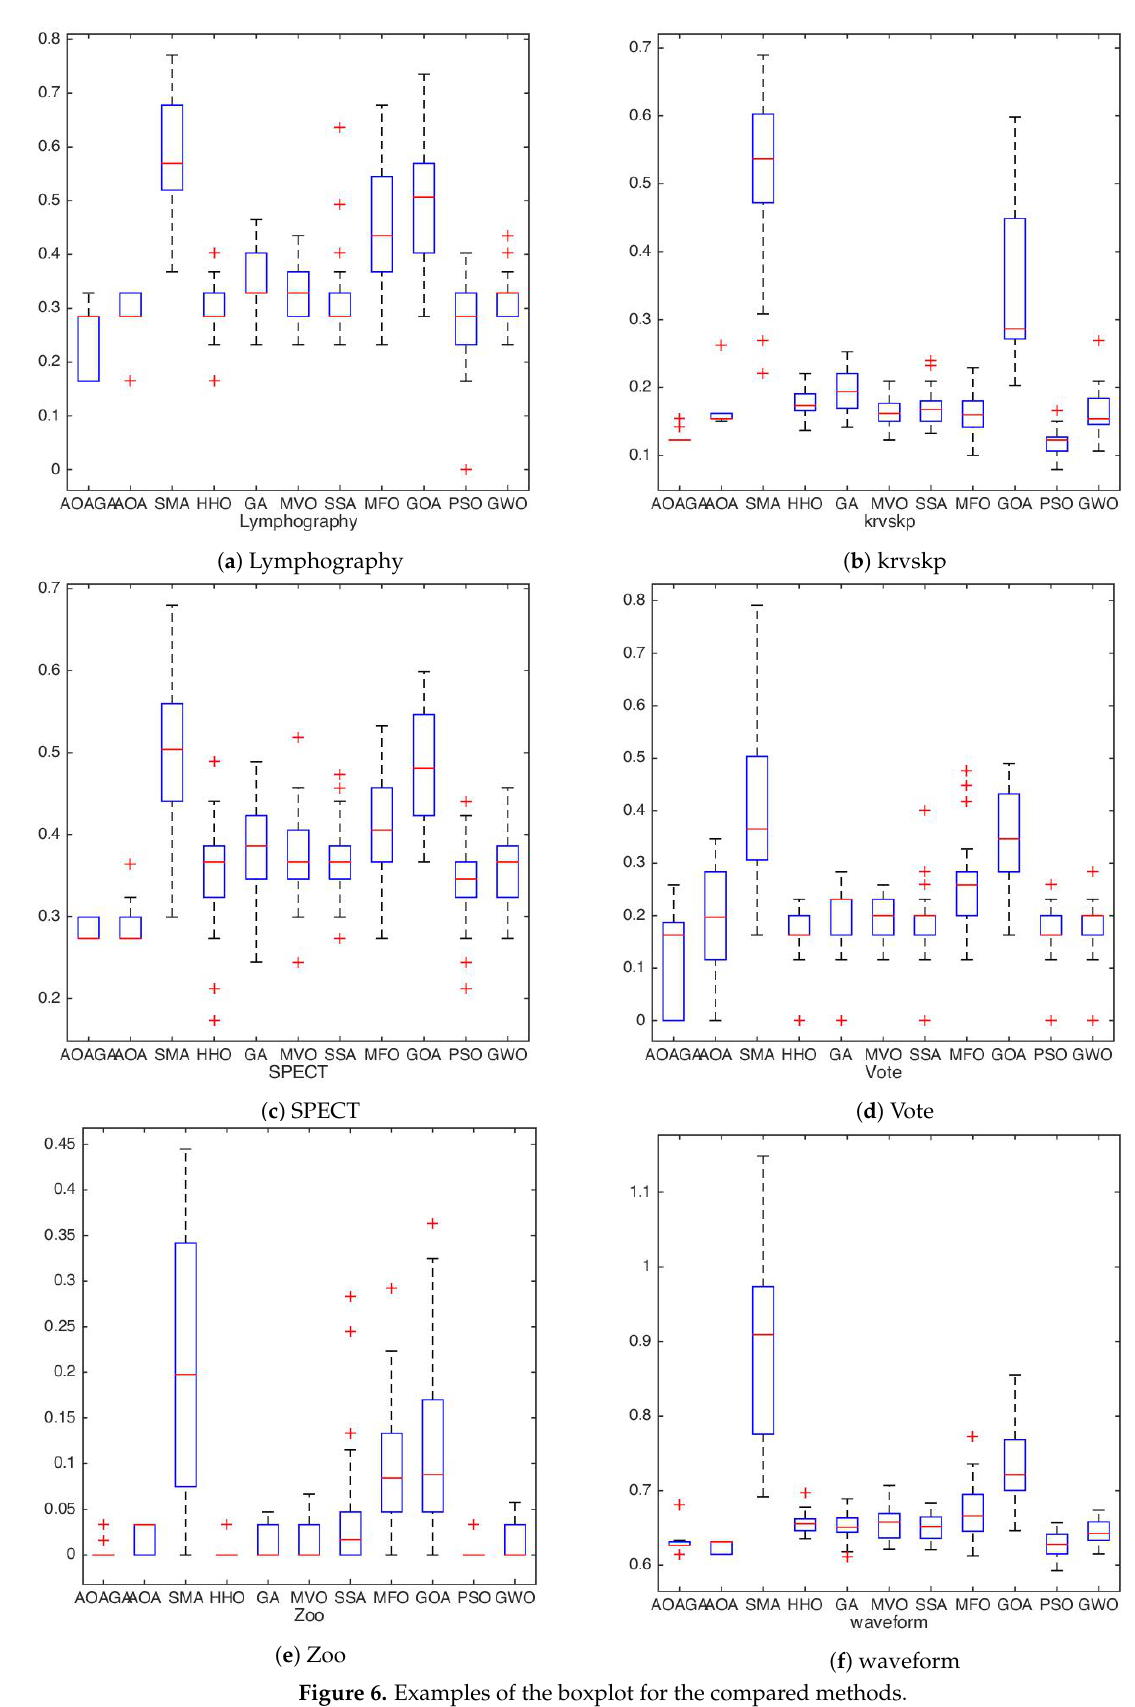
Figure 6. Examples of the boxplot for the compared